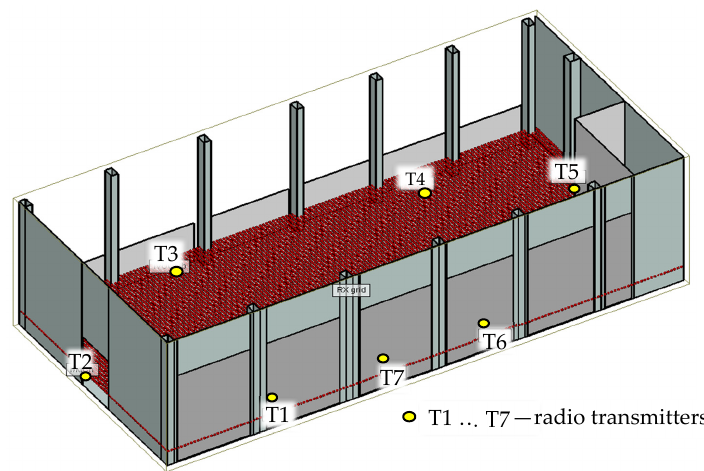
Figure 8. Simulation model of the indoor environment for the second verification scenario (S2).